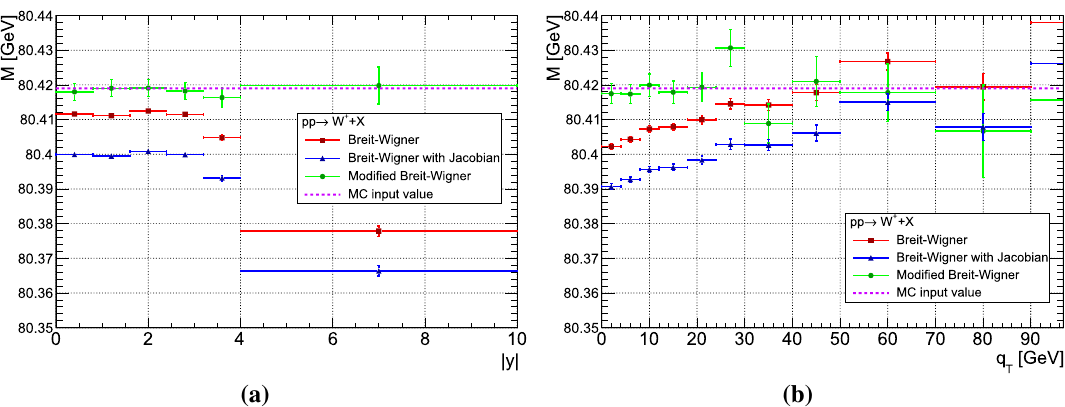
Fig. 4 The best-fit value of M W using the Breit–Wigner (red),Breit–Wigner with Jacobian (blue), and modified Breit–Wigner (green), in bins of + sample. The dotted line corresponds to the input value of M MC | y | (left) and q T (right),for the simulated W W −